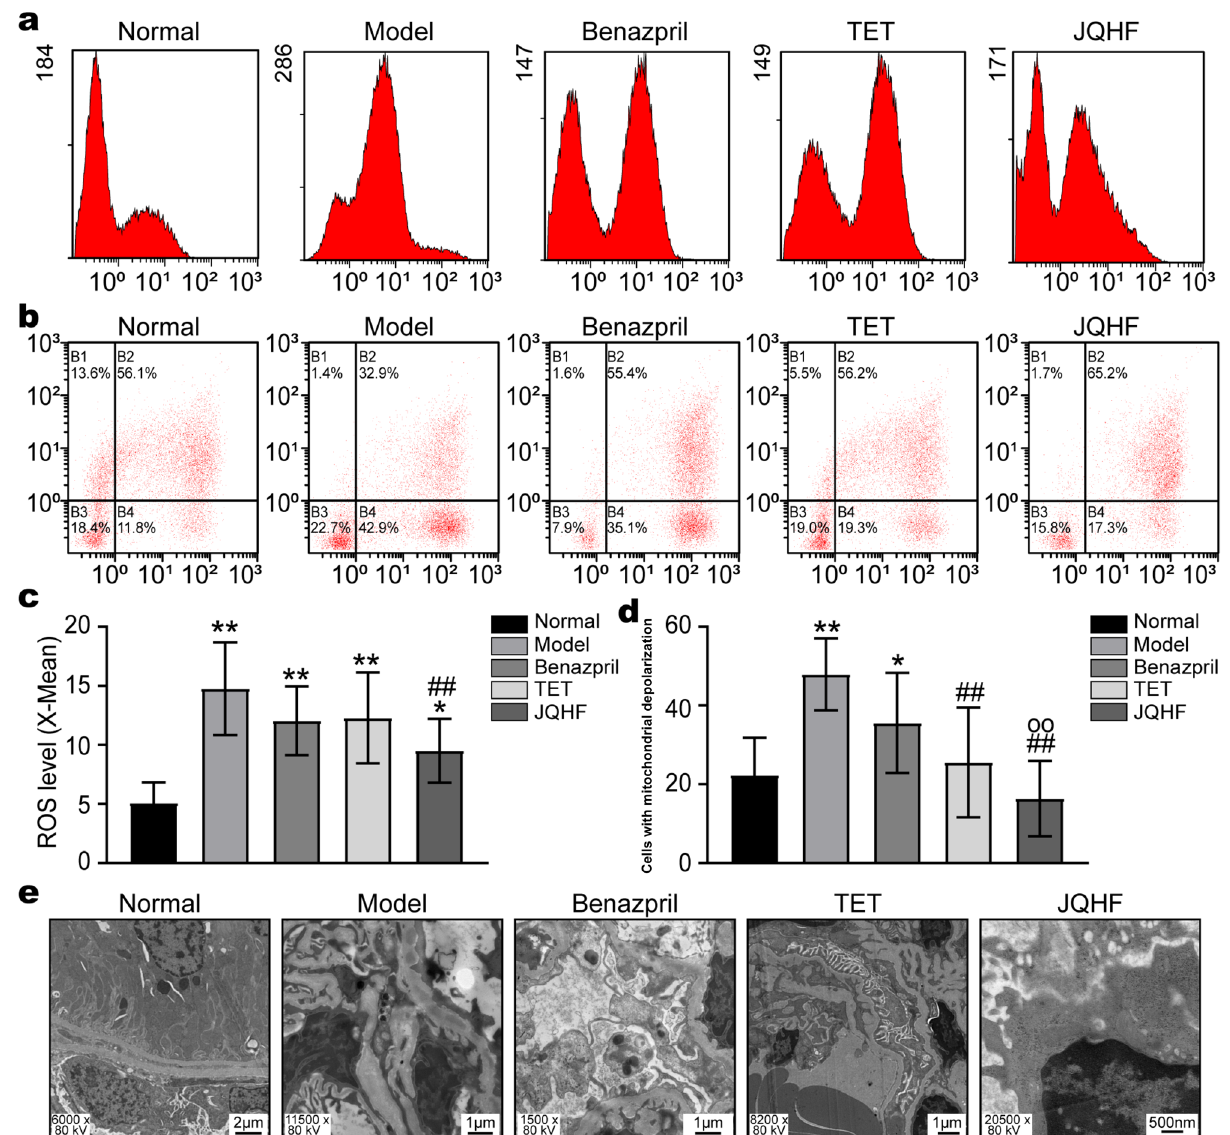
intracellular ROS level. ( d ) Quantitative analysis of MMP. ( e ) Analyze mitochondrial ultrastructural injuries by TEM. Data were analysed by one-way ANOVA followed by post hoc LSD test (c and d) and presented as the mean ± SD (n = 6). *P < 0.05 vs. Normal group, **P < 0.01 vs. Normal group, ## P < 0.01 vs. Model group and ○○ P < 0.01 vs. Benazepril